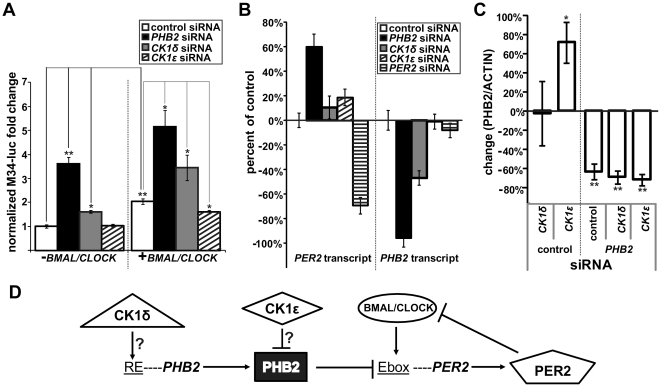
PHB2 is molecular clock component.(A) Representative graph (n = 3) of M34-luciferase reporter assays following transient cotransfections of M34-luc, renilla, GFP and indicated siRNAs without (left) or with (right) BMAL1 and CLOCK. (B) Representative graph (n = 3) showing transcript levels of PER2 and PHB2 24 h after transfecting cells with control, PHB2, CK1δ, CK1ε and PER2 siRNA. (C) Graph (n = 3) showing the effect of indicated siRNAs without (left, marked as control) or with (right, marked as PHB2) PHB2 siRNA on PHB2 protein levels relative to ACTIN. (D) Illustration summarizing molecular mechanism based on our results where shapes indicate proteins. (* indicates p<0.05; ** indicates p<0.01; determined by student t-test analysis. Error bars indicate STDEV).